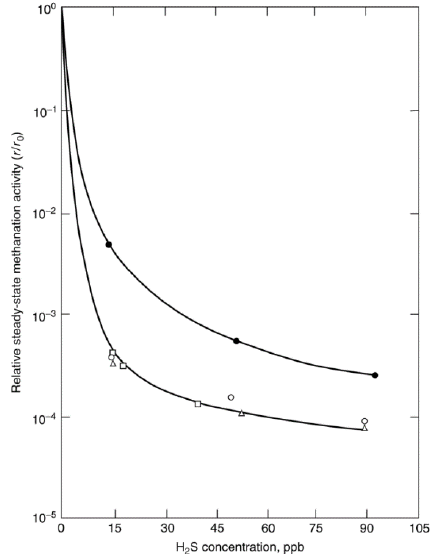
Figure 9. Relative steady-state methanation activity profiles for Ni (●), Co (Δ), Fe (○), and Ru (□) as a function of gas-phase H 2 S concentration. Reaction conditions: 100 kPa, 400 °C, 1% CO/99% H 2 for Co, Fe, and Ru, 4% CO/96% H 2 for Ni. Reproduced from [28]. Copyright 1982, Academic